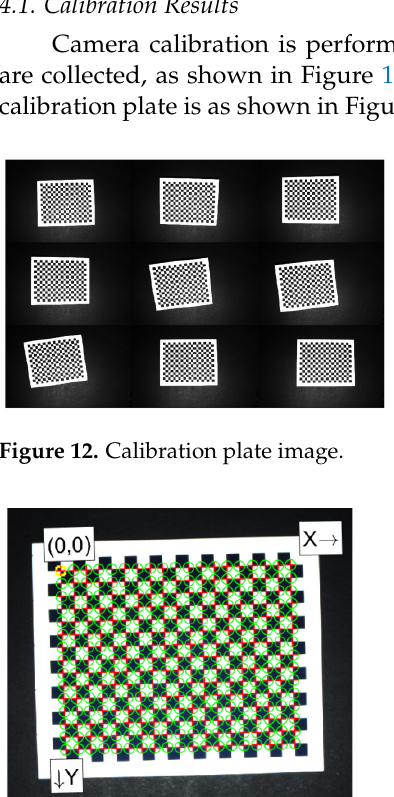
Figure 13. Corner detection of the calibration plate.